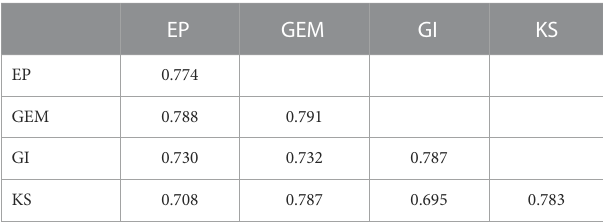
TABLE 2 Fornell – Larcker